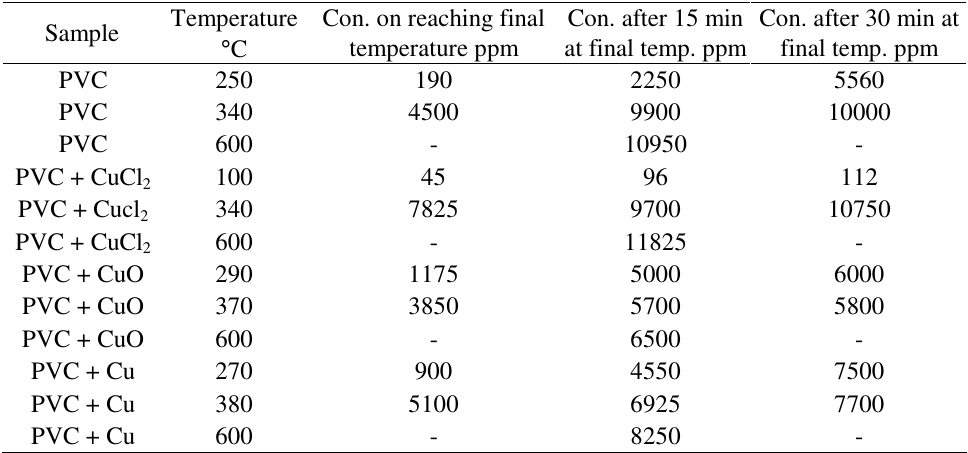
Table 1 . Concentration of Cl plus HCl in gas emission from the combustion of sample in air.